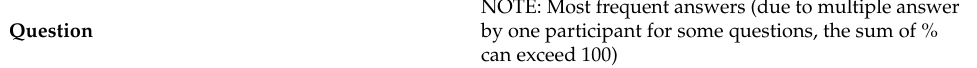
Table A2. Results of the descriptive